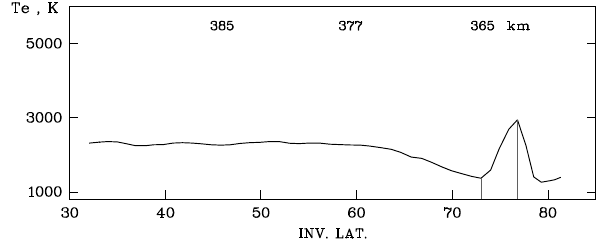
Fig. 1. Example of an electron temperature enhancement in the day- side polar region. Shown are data obtained by the DE-2 satellite on 18 January 1983 in the Northern Hemisphere. The measurements refer to a magnetic local time of approximately 13:10h and to mod- erate magnetic activity. The observation heights are indicated in the upper part of the figure. Vertical lines mark the equatorward bound- ary and the maximum of the temperature increase.